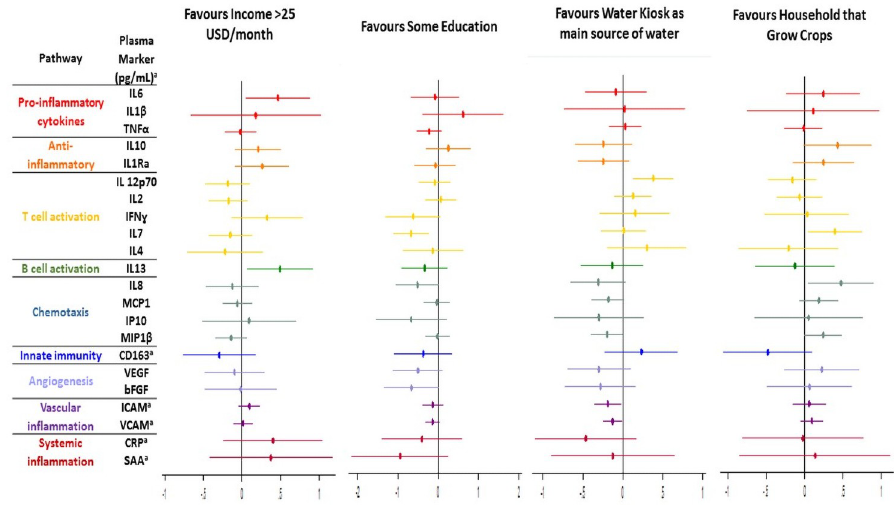
p = 0.056] and higher proportion of activated CD8 T cells [fold change 7.02% (-0.97 to 15.0); p = 0.085] (Figs 2 and 3). Amongst those earning more than 25 USD/month compared to those earning 25 USD/month or less, adjusted CD8 activation and exhaustion were both higher [activation fold change 12.7% (95% CI 7.75 to 17.78), p < 0.0001; exhaustion 6.77% (1.30 to 12.24), p = 0.016]. Levels of IL6 and IL13 were also higher amongst people with higher incomes [fold change (95% CI) 2.9 μ g/mL (1.13 to 7.6), p = 0.028; and 3.1 μ g/mL (1.2 to 8.3), p = 0.025 respectively]. Proportions of nonclassical monocytes were lower amongst this higher income bracket with lower intermediate monocytes trending towards significance [nonclassi- cal fold change -5.23 (95%CI -8.94 to -1.53), p = 0.006; intermediate -1.91 (-3.91 to 0.10), p = 0.063].